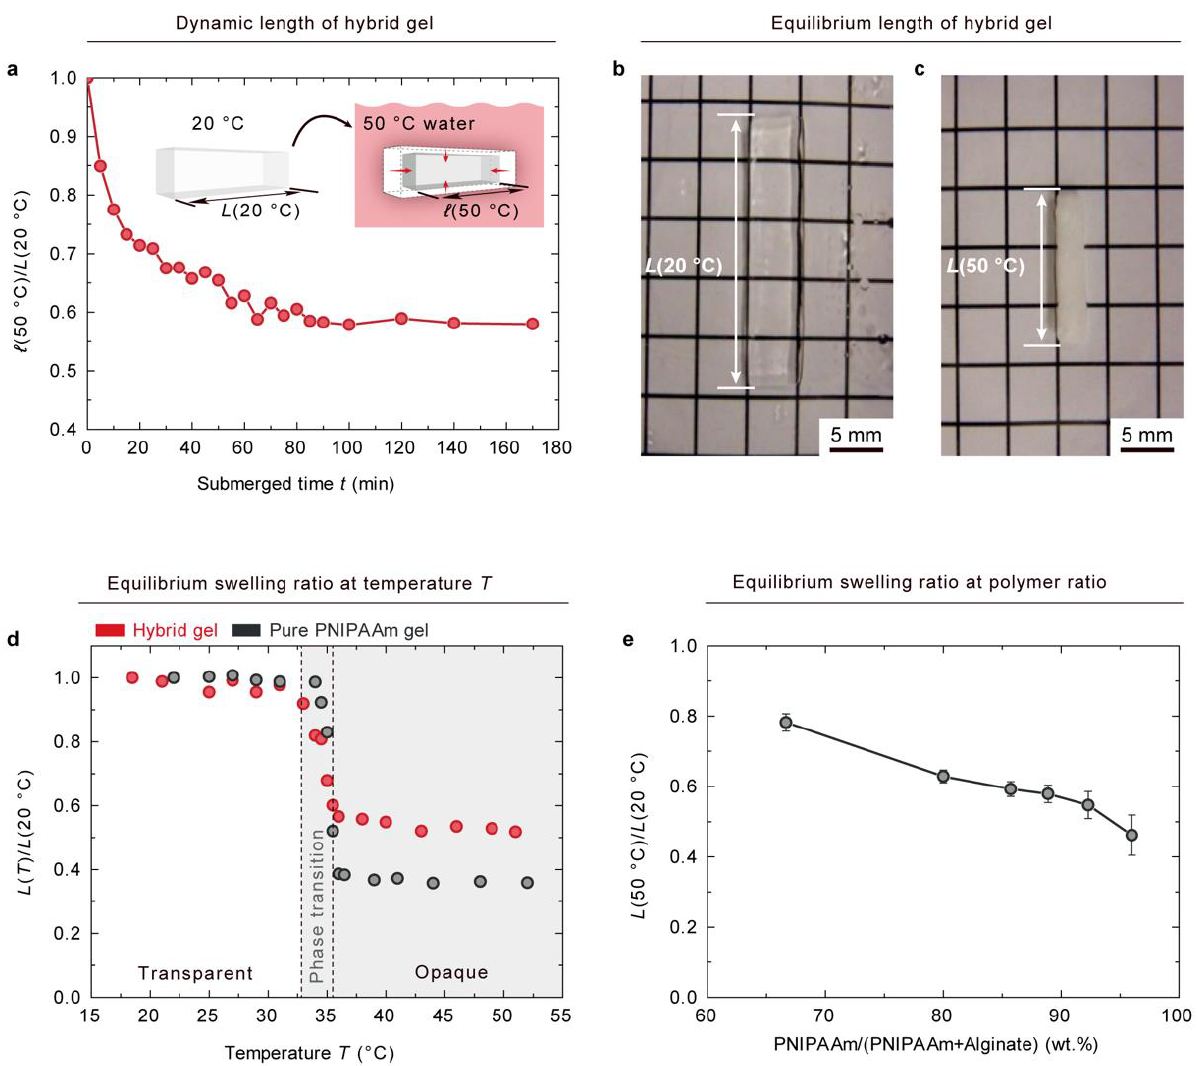
Figure 3. Thermo-sensitive behaviors of PNIPAAm–alginate hybrid gel. ( a ) 20 × 5 × 3 mm 3 PNIPAAm–alginate hybrid gel, which was fully swollen in 20 °C water, was submerged into 50 °C water. Dynamic length in 50 °C water, (cid:96) (50 °C ), was captured as a function of submerged time. The dynamic swelling ratio, (cid:96) (50 °C )/ L (20 °C ), of a hybrid gel reached an equilibrium state after 100 min, which is near the theoretical self-diffusion time of 94 min in 50 °C water. ( b ) Hybrid gel of PNIPAAm-10.33-0.17/alginate-1.29-22.77 fully swollen in 20 °C water. Equilibrium length of the gel in 20 °C water is called L (20 °C ). ( c ) After being submerged in 50 °C water, the gel reached another equilibrium state with a length of L (50 °C ). ( d ) Comparison of equilibrium lengths at temperature T , L ( T ), of pure gel and hybrid gel. For each data point, the sample was stored under a designated temperature for 4 h to reach an equilibrium state. Both pure and hybrid gels underwent phase transition in a similar temperature range from 32 to 35 °C. However, the equilibrium swelling ratios, L ( T )/ L (20 °C ), of pure gel and hybrid gel reached steady values of 0.35 and 0.52, respectively. ( e ) Equilibrium swelling ratio of hybrid gel plotted as a function of weight ratios of PNIPAAm/(PNIPAAm + alginate). (Error bars show standard deviation; n ≥ 3 )